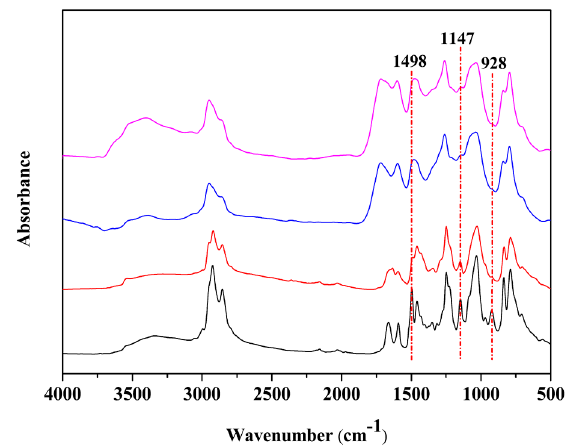
Figure 7. FT-IR spectra of poly (SIE-b) at different curing stages.